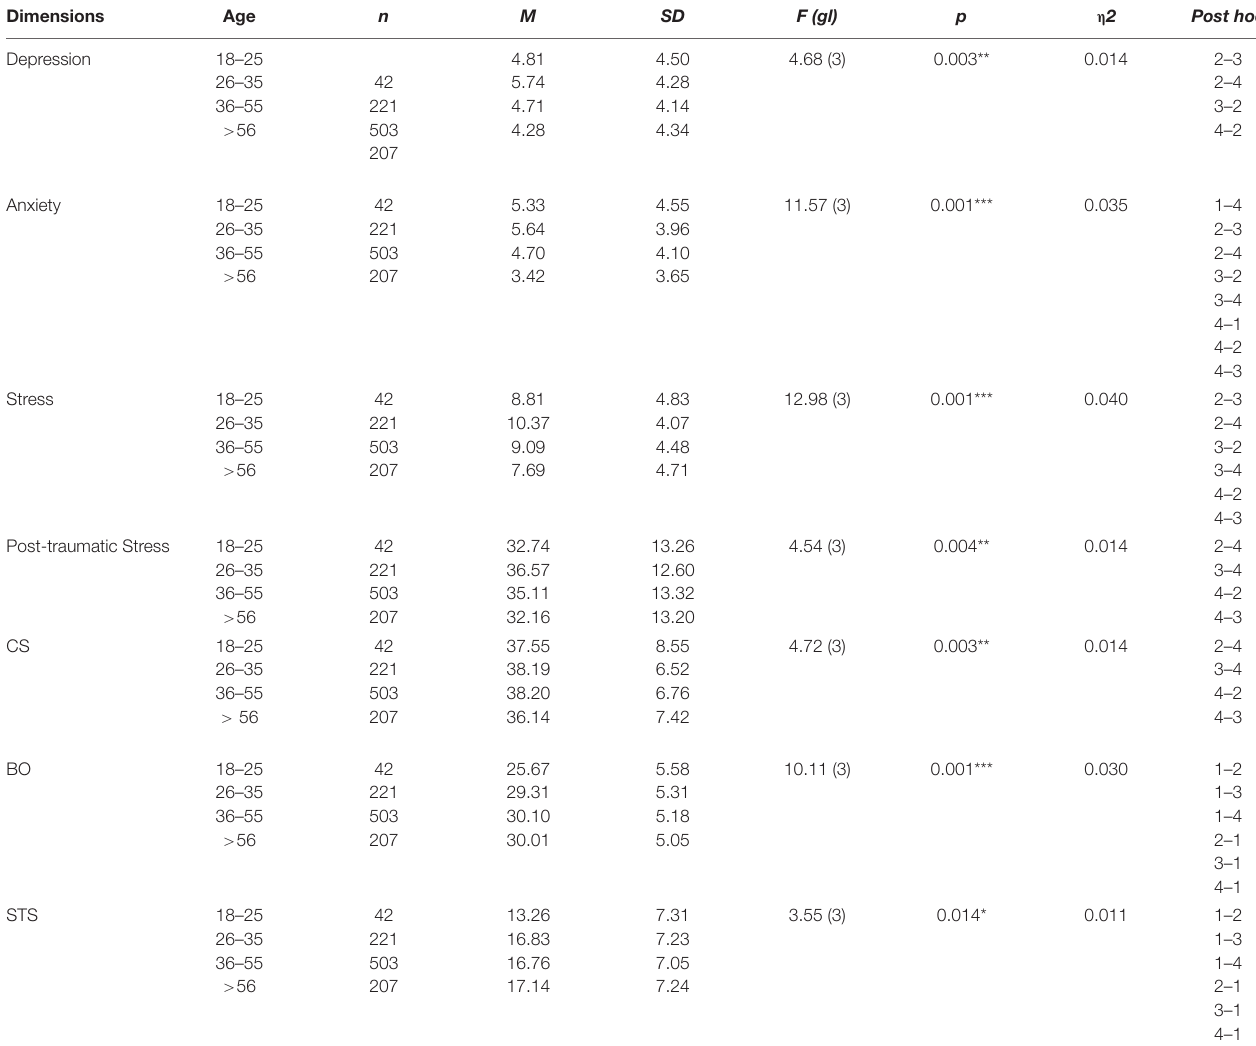
TABLE 4 | Differences in the means of the variables under study according to the age of the participants. Dimensions Age n M SD F (gl) p η 2 Post